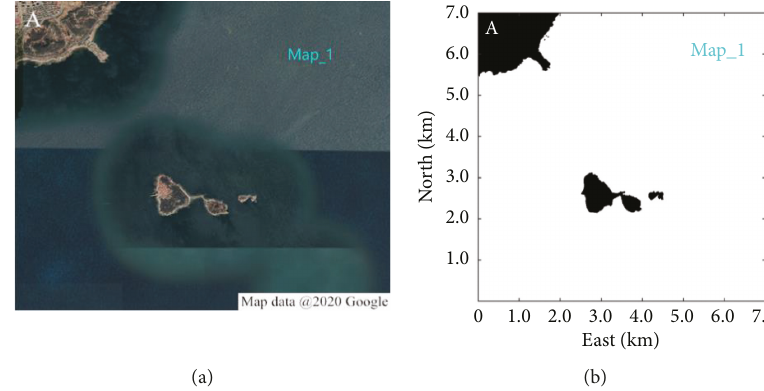
Figure 17: 700 ∗ 700 (7km ∗ 7 km) scale sea area map. (a) Original map. (b) Binarized map.